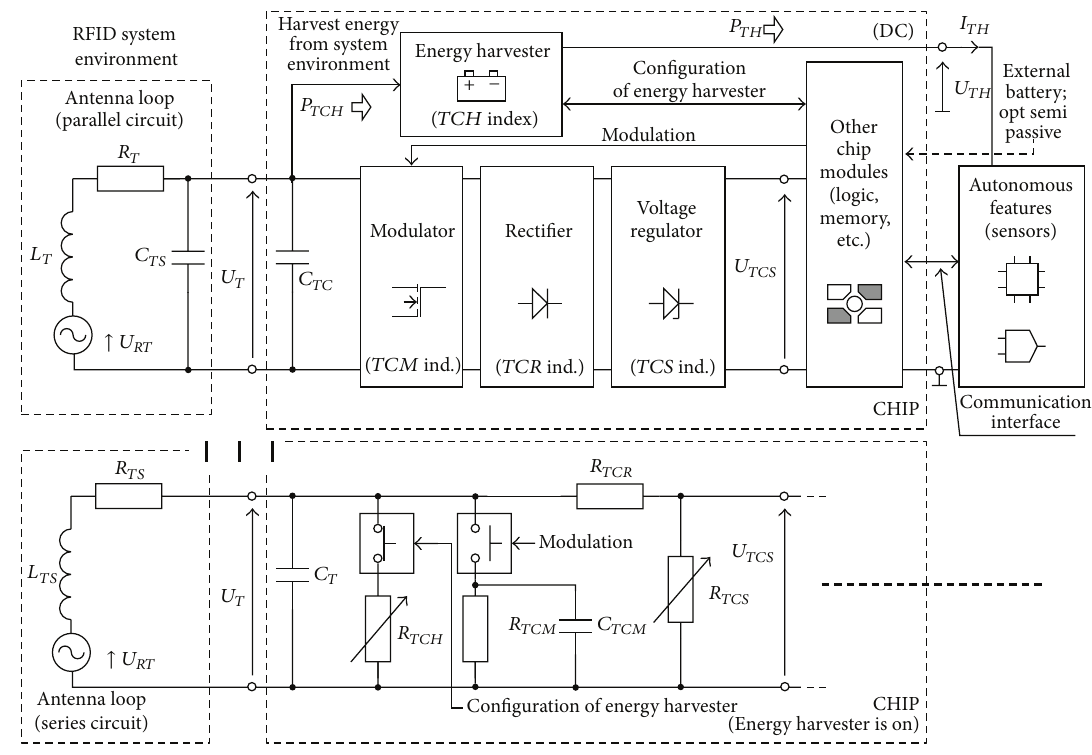
Figure 3: Model and electric equivalent of passive RFID transponder with energy